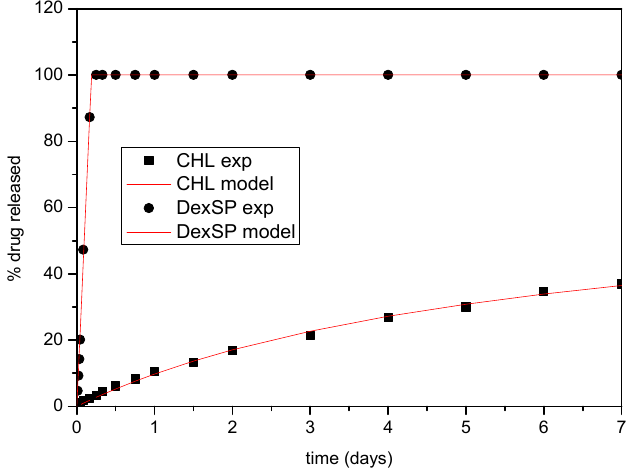
Figure 11. Comparison between model (solid lines) and experimental (symbols) release curves for pure drugs.